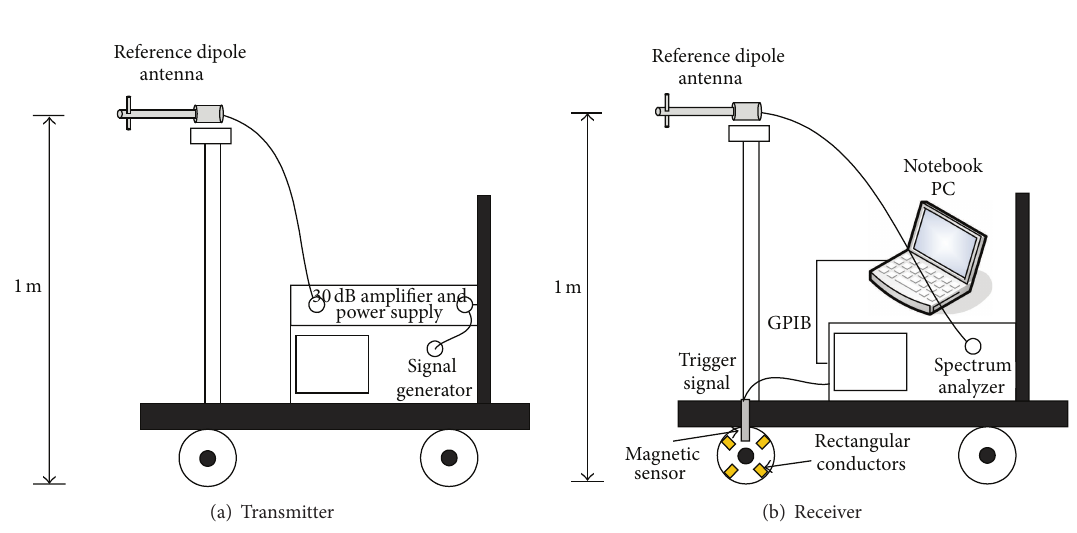
Figure 3: Experimental site.